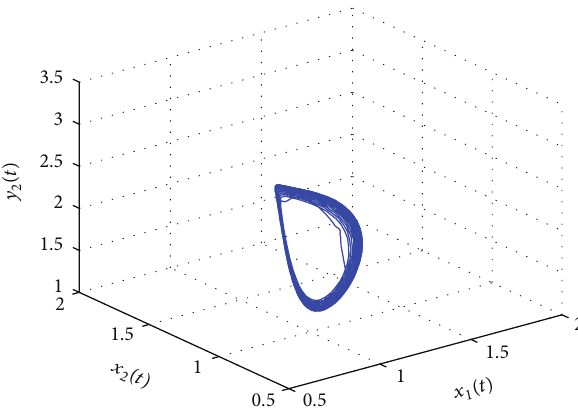
Figure 18: The phase plot of the states 𝑥 2 , 𝑦 1 , 𝑦 2 for 𝜏 = 3.2500 > = 3.1043 𝜏 0